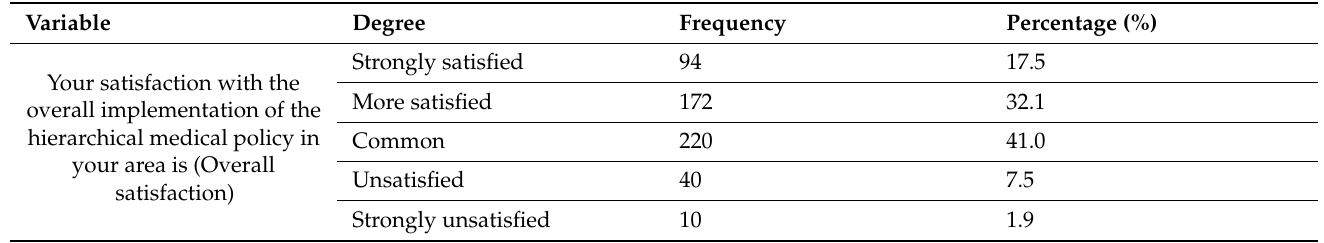
Table 10. Statistics on the overall satisfaction of the hierarchical medical policy.